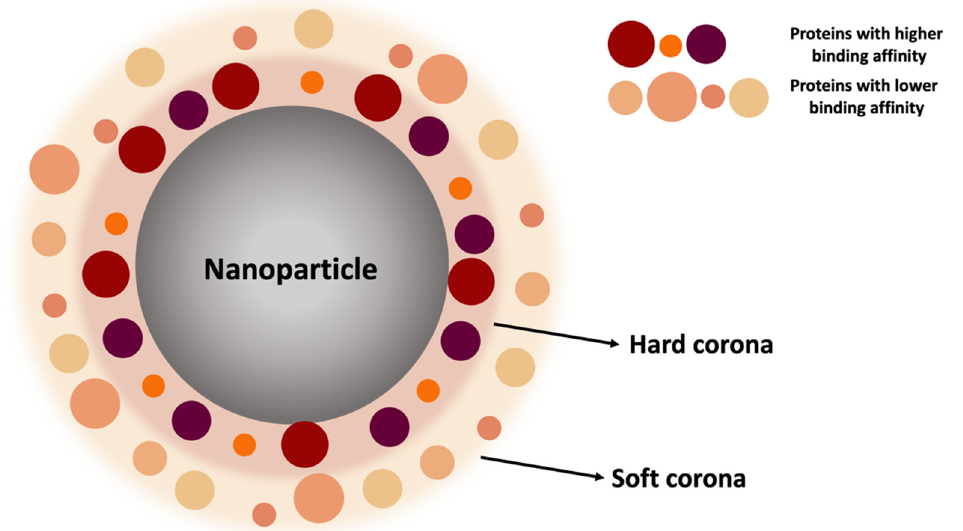
Figure 5. The duality of the protein corona. Proteins with a smaller size and lower affinity constitute the so-called “soft” corona. They are loosely attached to the NPs’ surface and relocate from the NPs’ surface rapidly. This promotes the replacement of less abundant proteins with those with higher affinity belonging to the “hard” corona.